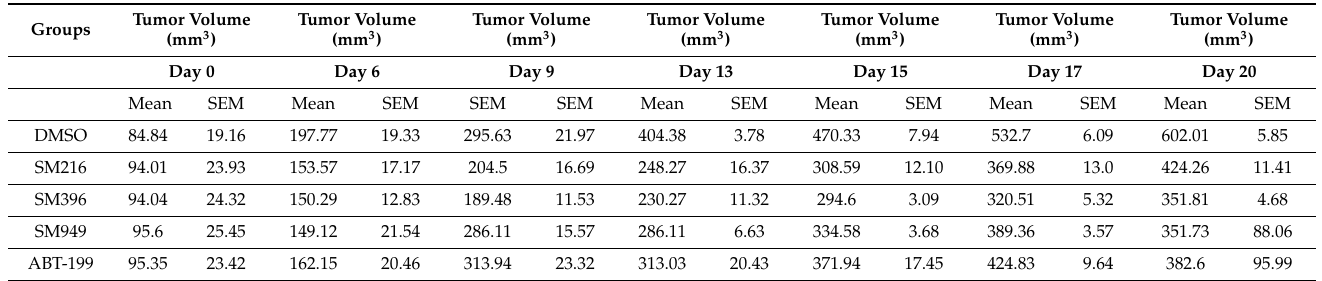
Table 3. Mean tumor volumes of athymic mice with MDAMB-231 xenografts after